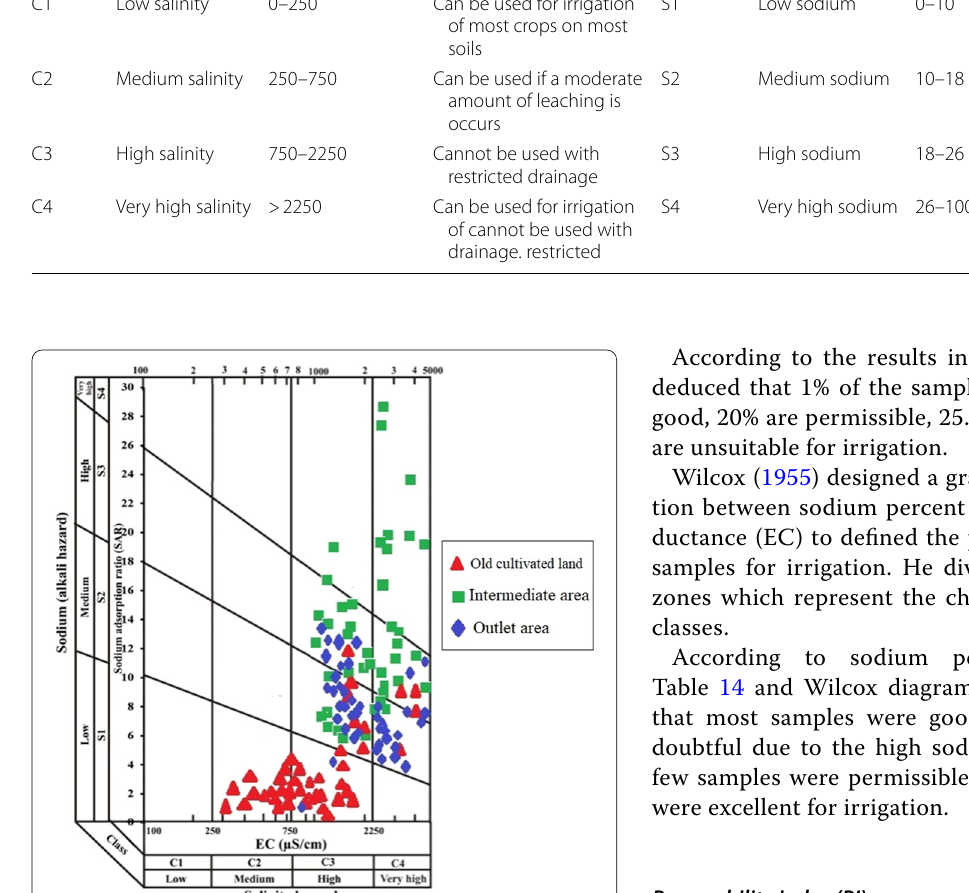
Fig. 12 Groundwater suitability for irrigation for the available groundwater samples in the (red triangle) old cultivated land area, (blue diamond) outlet area and (green square) intermediate area according to US Lab. Classification